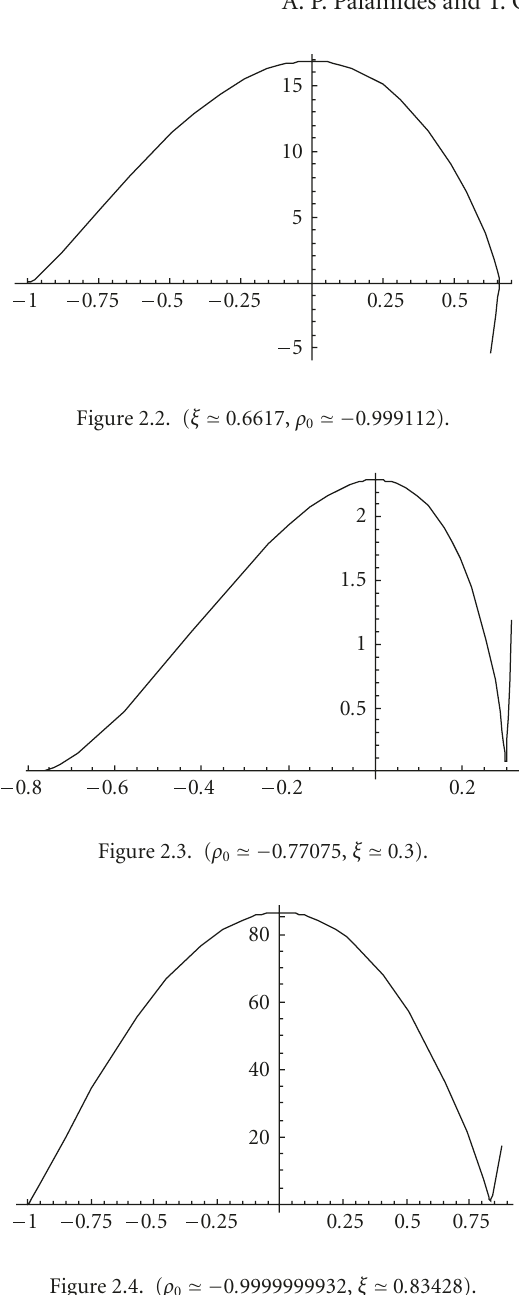
Figure 2.4. ( ρ 0 (cid:8) − 0 . 9999999932, ξ (cid:8) 0 .